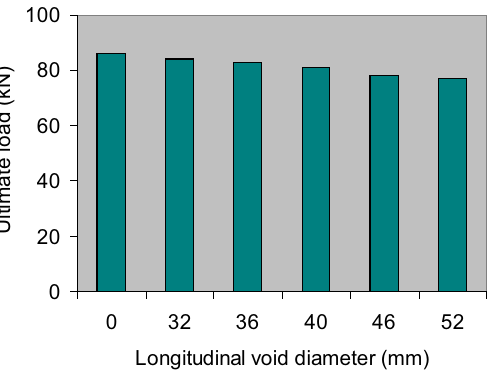
Fig. 5 Influence of longitudinal void diameter on the cracking load